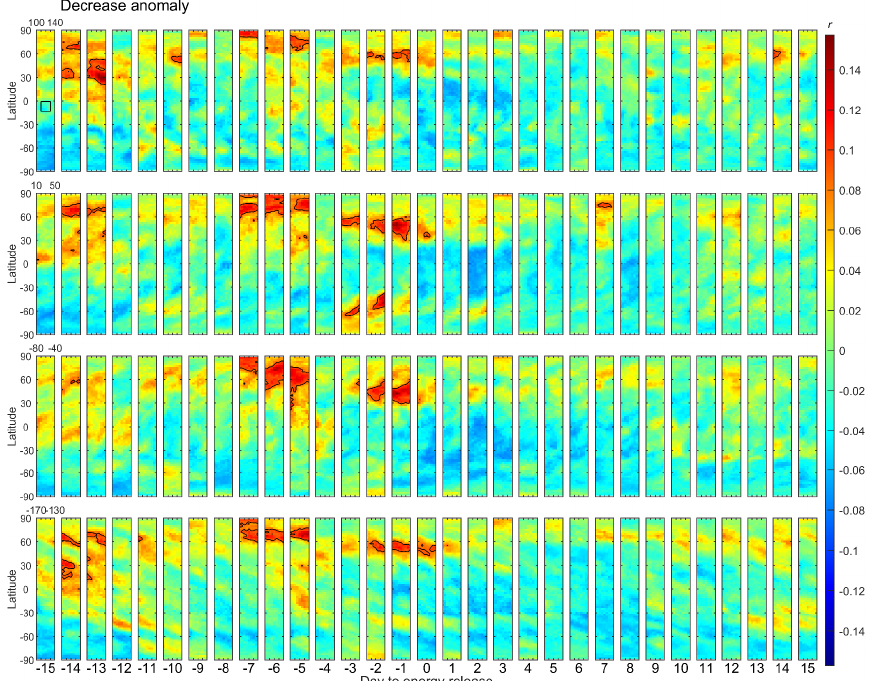
Figure 4. Same as Figure 2 for the results of occurrence times of both the TEC increase and decrease anomalies counted together.